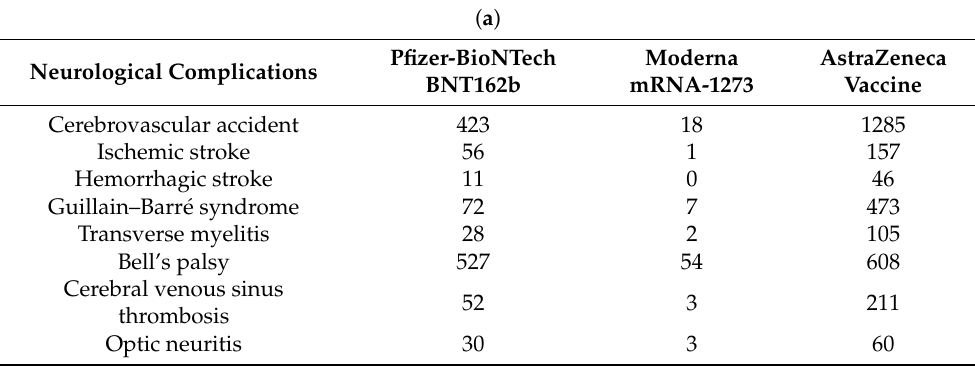
Table 1. Medicines and Healthcare products Regulatory Agency (MHRA) data as of 12/15/21. Vaccine adverse events reporting system (VAERS) data as of